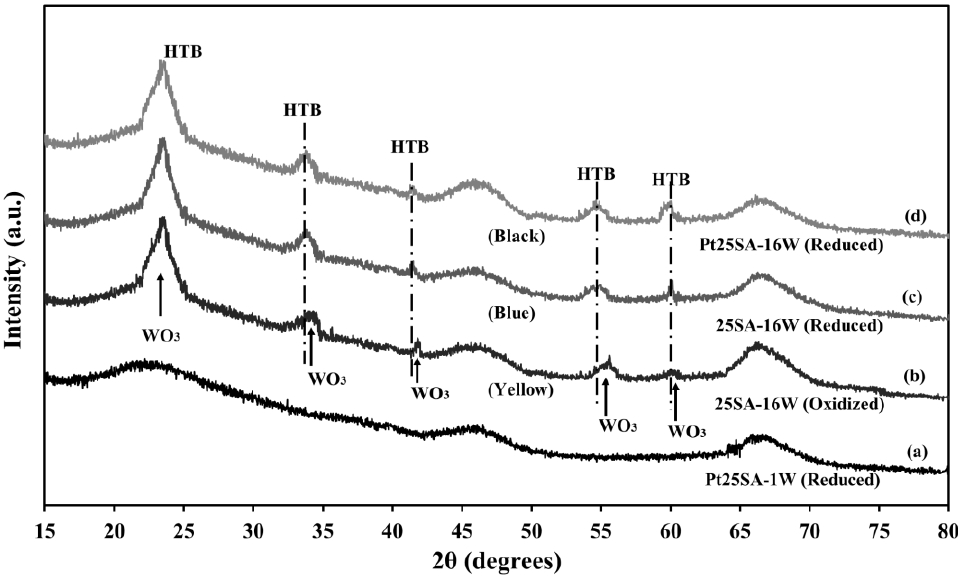
Figure 9. XRD of selected Pt‒WOx samples: ( a ) Pt25SA‒1W reduced gray color, ( b ) sample calcined 25SA‒16W, yellowish color, ( c ) sample 25SA‒16W reduced at 500 °C in H 2, blue color, and ( d ) Pt25SA‒16W catalyst reduced at 500 °C in H 2 , black color.